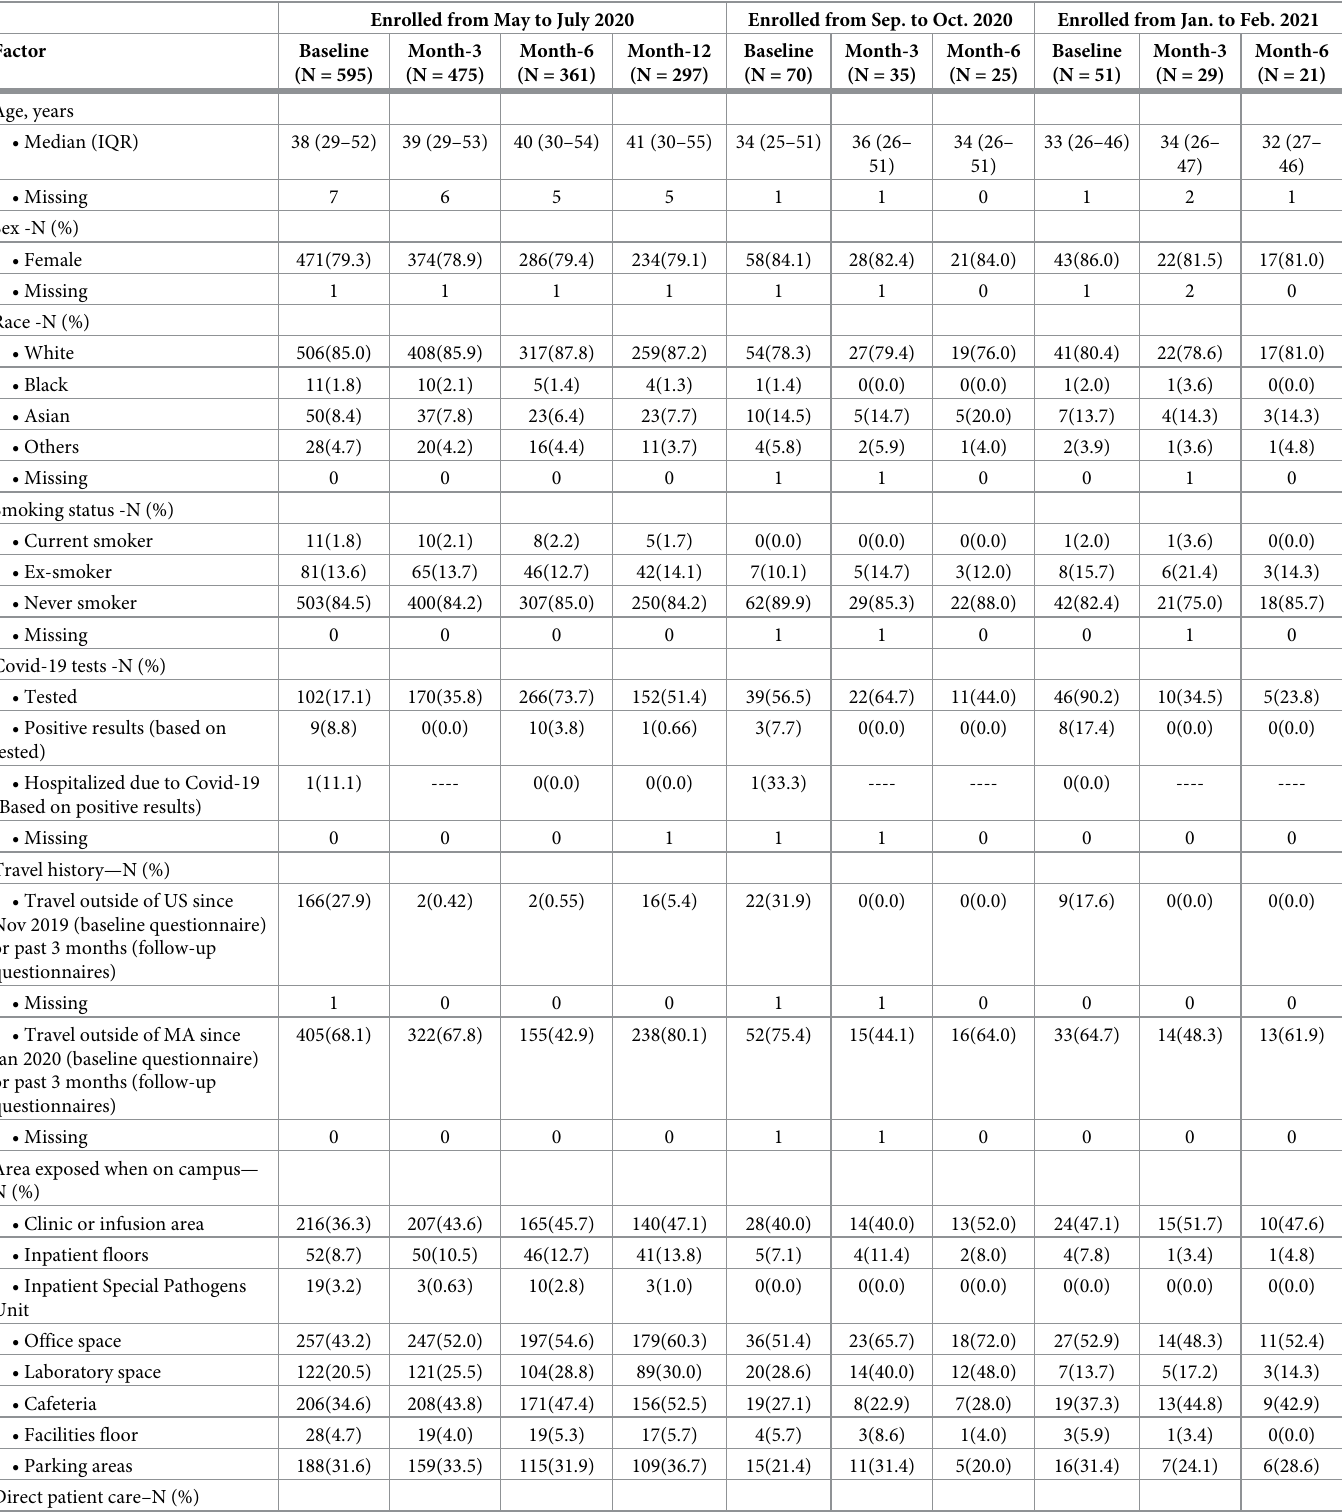
Table 1. Baseline participant